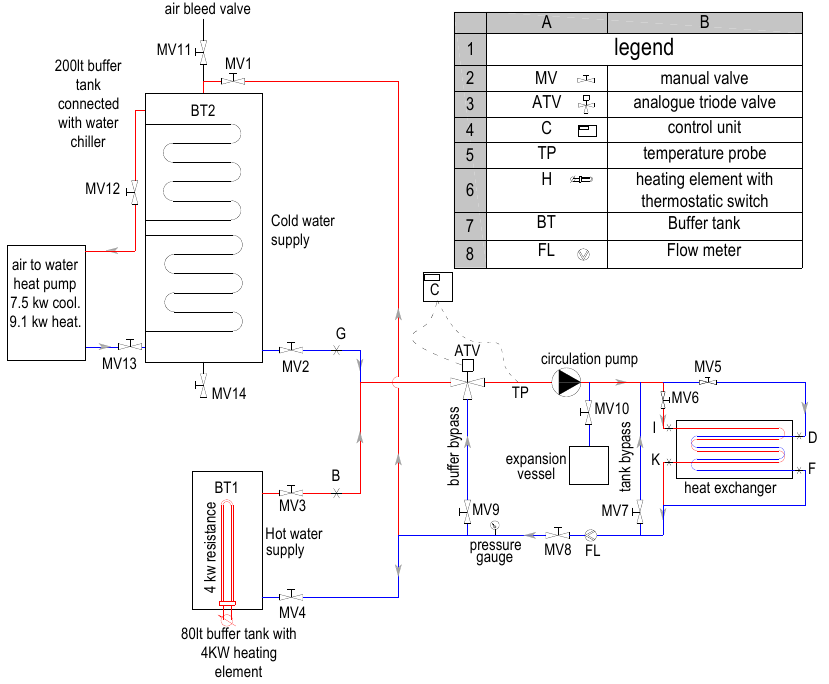
Figure 1. Test rig hydraulic drawing.